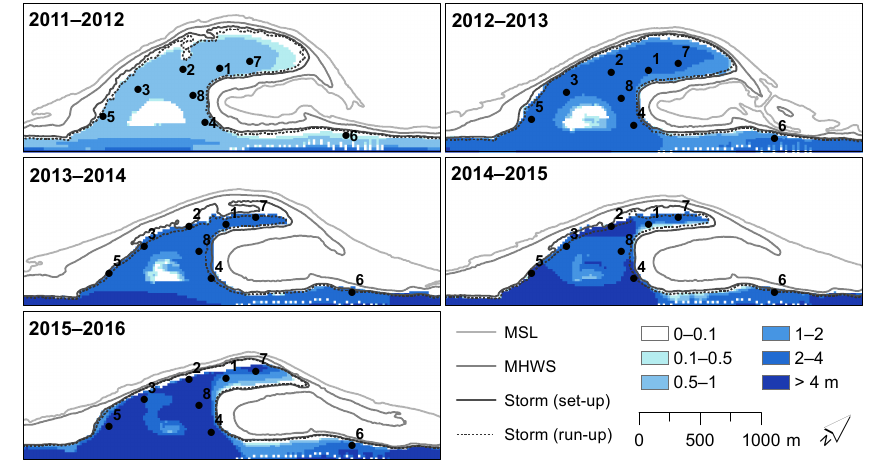
Figure 11. Thickness of fresh groundwater lens (in metres) 1, 2, 3, 4, and 5 years after the construction of the Sand Engine, with contour lines of the MSL, MHWS, and (estimated) maximum wave setup and wave runup height of every yearly period.